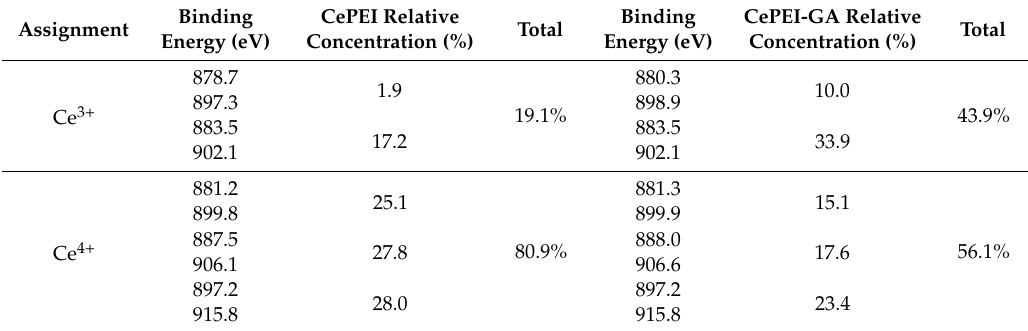
Table 1. Ce oxidation states obtained from the deconvolution of Ce 3d high resolution spectra. Binding CePEI Relative Assignment Energy (eV) Concentration (%)